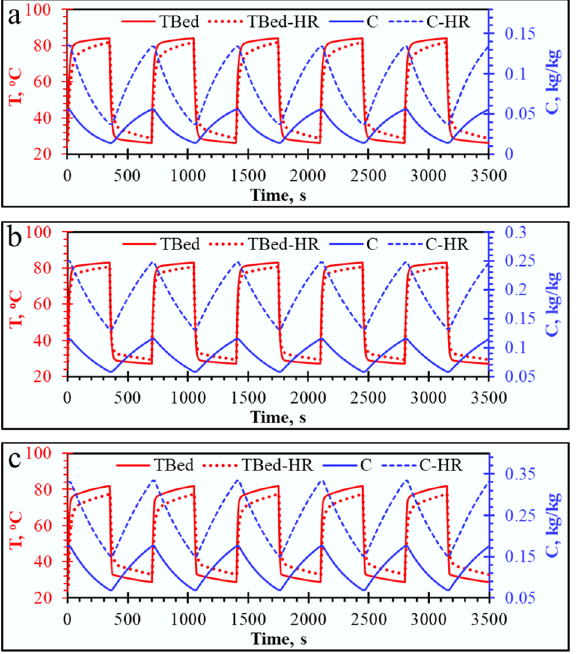
Fig. 7 Comparison of the TBed and the change in C during adsorption cycle for ACD and AD-HR cycles utilizing. a Raw Max, b Max/HCl, and c Max/(NH 4 ) 2 CO 3 adsorbents. Due to working the adsorption cycle at an upper evaporation pressure than the ACD cycle, the highest water Ad-C occurs with the AD-HR cycle.